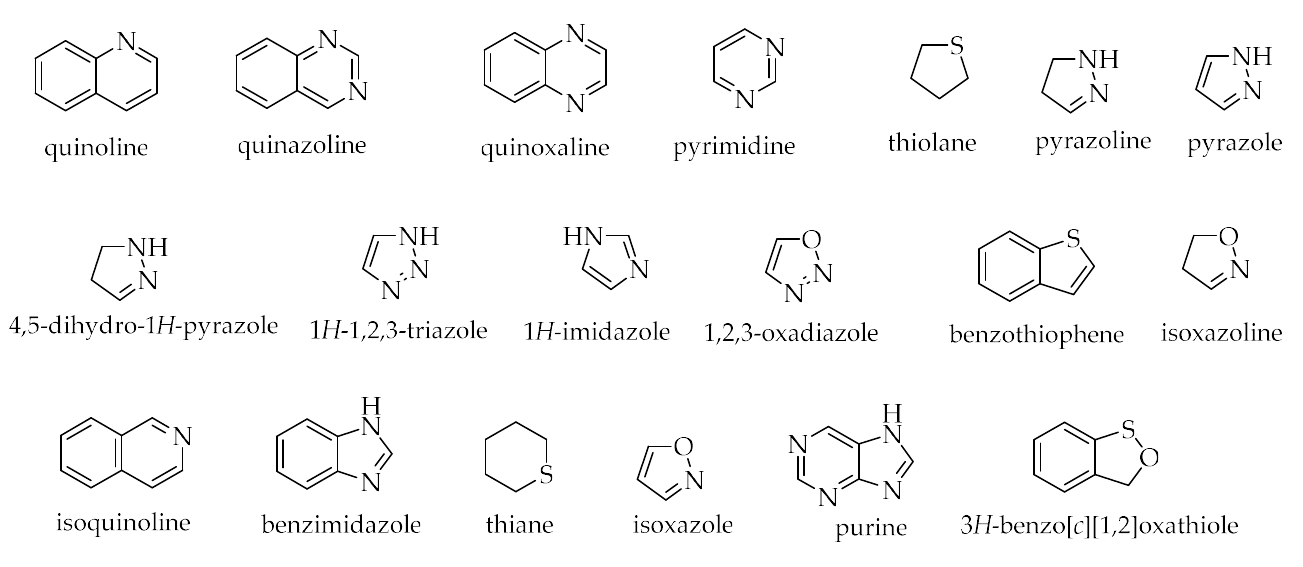
Figure 3. Examples of heterocyclic chemotypes .